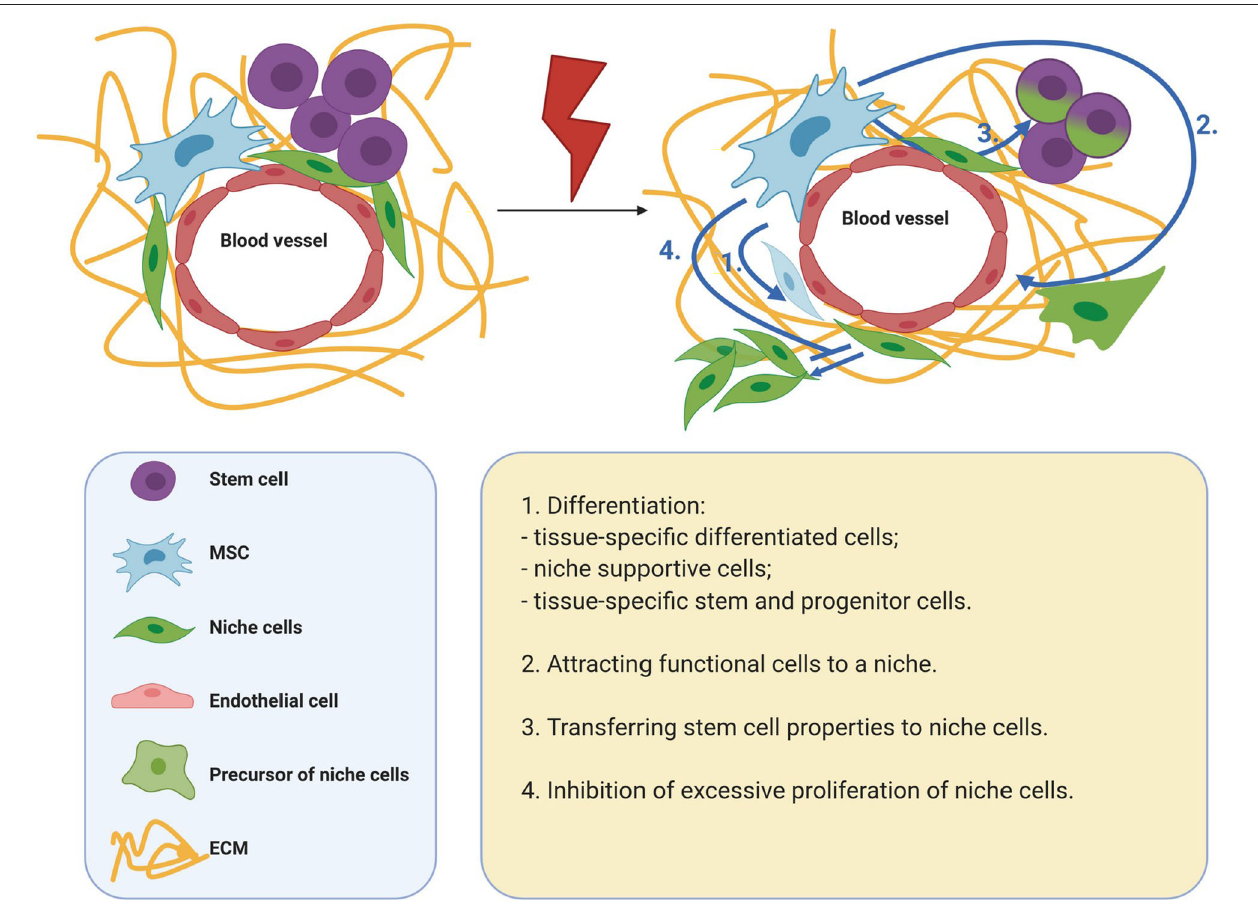
FIGURE 1 | Mechanisms of MSC participation in tissue regeneration. MSCs are able to differentiate into some niche components, as well as attract functional cells to a niche. MSCs are able to replenish the stem cell pool by endowing differentiated cells with stemness. A significant contribution of MSCs to tissue regeneration can be achieved due to their prevalence in tissues and the ability to respond to metabolic, mechanical, biological paracrine stimuli of the microenvironment with high plasticity. MSCs, mesenchymal stromal cells; ECM, extracellular